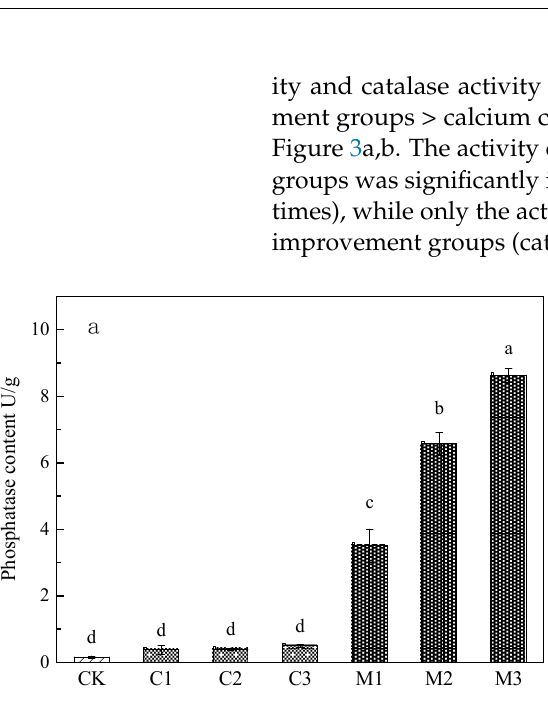
Figure 2. Content of organic matter in tailings treated with modifier.